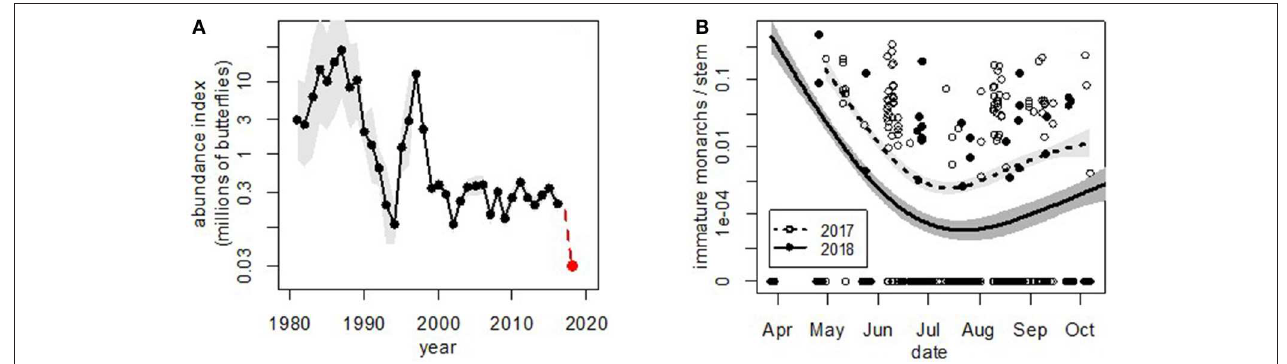
FIGURE 2 | Western monarch abundance at (A) overwintering and (B) breeding sites. In both panels, shaded areas show 95% confidence limits. (A) Western monarch butterfly 1981–2018 estimates for overwintering abundance during the Thanksgiving Count time period in coastal California. Estimates for 1981–2017 were calculated with state space models (Schultz et al., 2017), scaled to be comparable to the raw count from 2018 (shown). (B) Monarch egg and larva counts per stem at all 12 monitoring sites (shown in Figure 1 ) throughout the season in 2017 and 2018. Curves were fitted with generalized additive models (Wood, 2011) to show general trends in abundance. The fact that the two curves are parallel suggests that densities were lower by the time monarchs arrived in 2018; the decline does not appear to be due to different dynamics during breeding. Note the log scale and 10-fold difference among